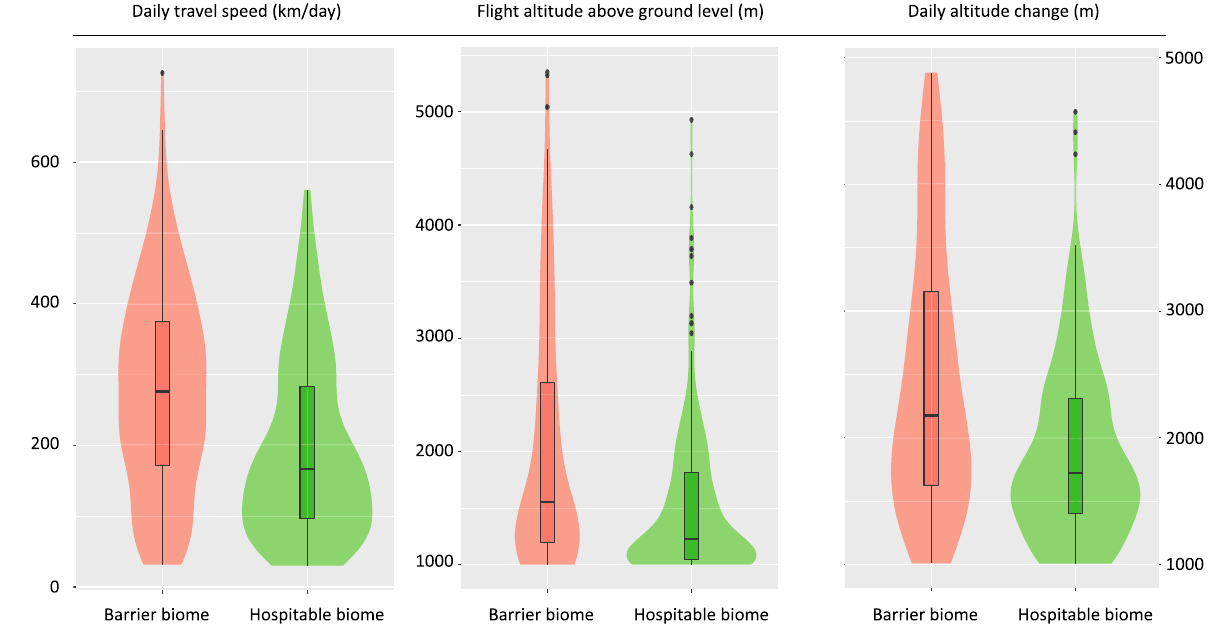
Figure 3. Box plots and violin plots showing ( A ) daily travel speed (n = 408 days; 19 individuals), ( B ) flight altitude above ground level (n = 408 days; 19 individuals), ( C ) daily altitude change (n = 338 days; 5 individuals) in relation to biome category. Violin plot: probability density. Box plot: median (thick black line), 25% and 75% quantiles (thin box), 90% range (whiskers) and outliers.